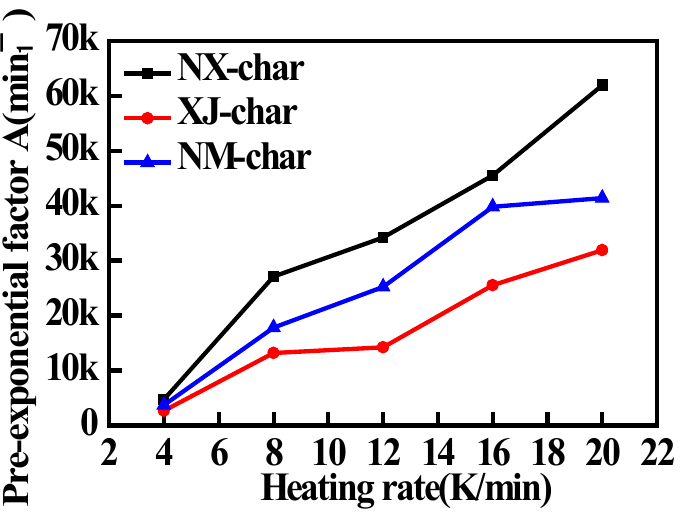
Figure 5. Pre-exponential factors A obtained for the chars derived from the NX, XJ, and NM coal sources as a function of the heating rate.